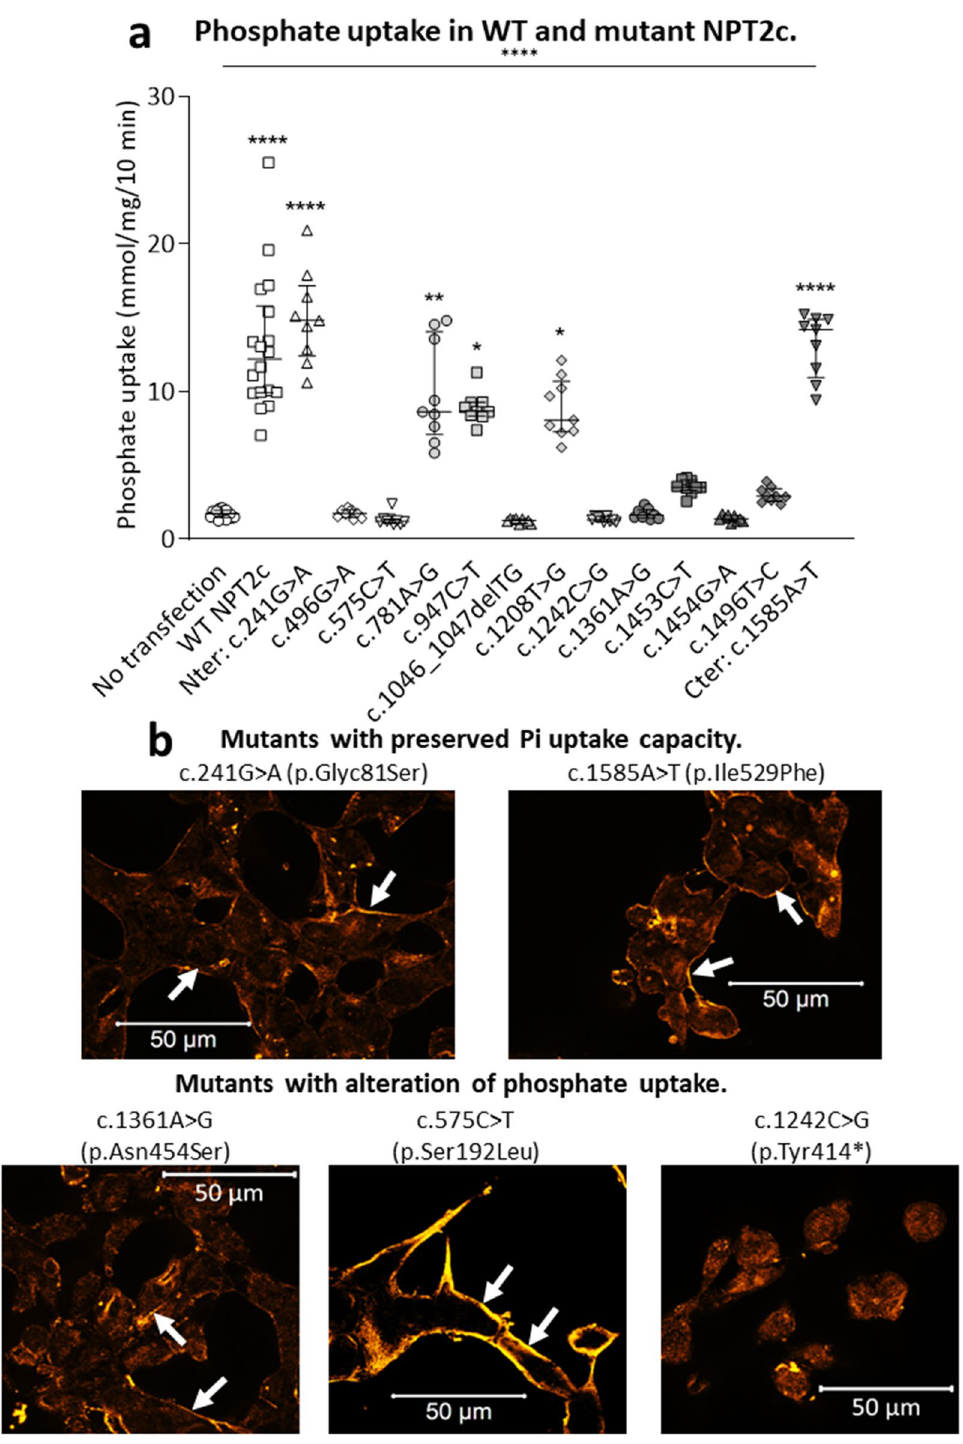
Figure 3. In vitro characterization of the NPT2c variants. ( a ) Na-dependent phosphate uptake: HEK expressing WT NPT2c or NPT2c variants (cells transfected with 0.5 μg of DNA and 1 μl of lipofectamine 2000 per well). 1 variant transport phosphate normally, 4 variants have a phosphate transport function slightly lowered et 8 have a strong decrease in phosphate transport. Quantitative data represent at least 9 independent experiments. Statistical analysis was performed using a non- parametric Kruskall–Wallis test followed by Dunn’s multiple comparison post-hoc test. ****p < 0.0001, simple line represents Kruskall–Wallis test. *p < 0.05, **p < 0.01, ****p < 0.0001 on NPT2c conditions represent Dunn’s multiple comparison post-hoc test compared to non- transfected cells. ( b ) We performed immunofluorescence on HEK cells transfected with transporting and non-transporting NPT2c variants (cells transfected with 0.5 μg of DNA and 1 μl of lipofectamine 2000 per well). All the transporting variants were correctly addressed at the plasmic membrane. Some of the non-transporting variants were not addressed at the plasmic membrane (e.g. c.1242C > G, p.Tyr414*), others were correctly addressed at the plasmic membrane (e.g. c.575C > T, p.Ser192Leu and c.1361A > G,